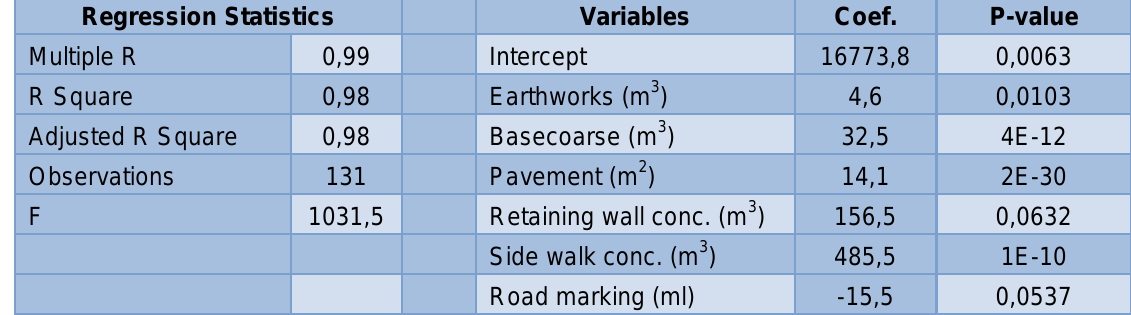
Table 7 Multiple regression results among total project cost and activities'